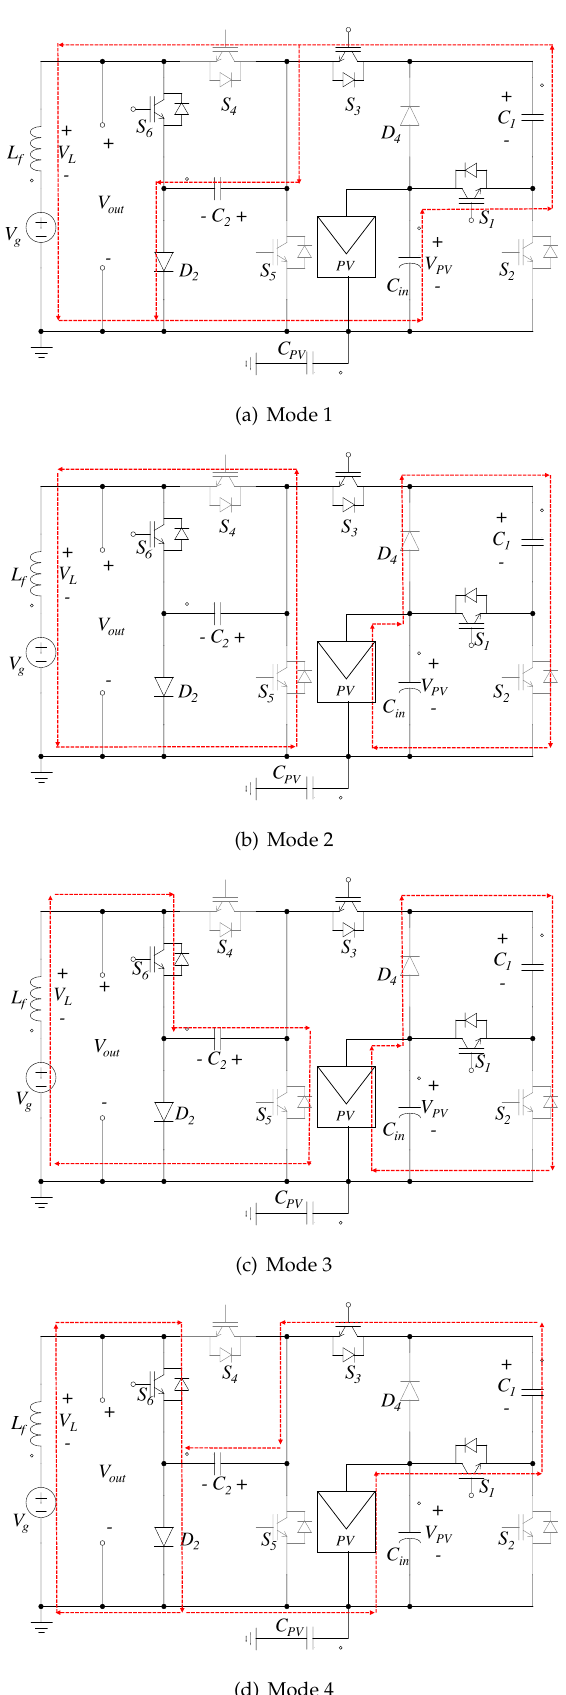
Figure 8. Operating modes of the proposed grid-tied inverter in Reference